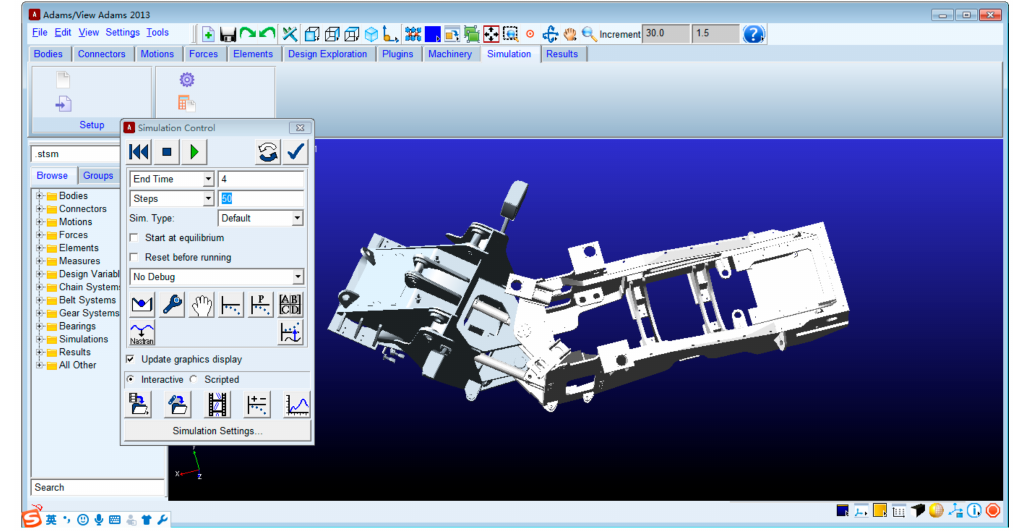
Figure 8. The after-optimization steering model of FW50GL in